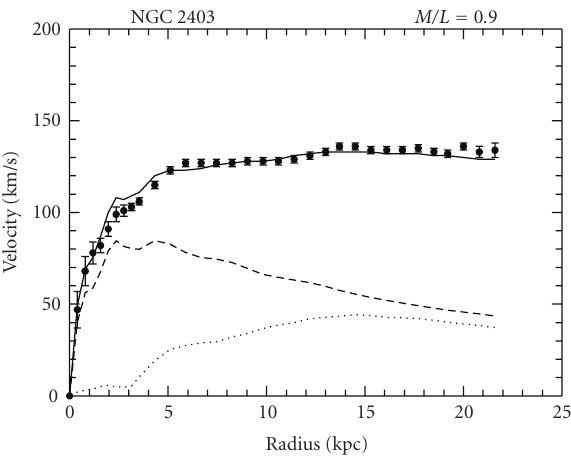
Figure 1: The 21 cm line rotation curve of the spiral galaxy NGC 2403 (points with error bars). The dashed curve shows the Newtonian rotation curve of the visible disk, assuming a constant mass-to-light ratio of 0.9 in solar units. The dotted curve is Newtonian rotation curve due to the gaseous component (hydrogen plus primordial helium). The solid curve is the MOND rotation curve. One should bear in mind that such theoretical curves also possess error bars, or a range of confidence, due to observational uncertainties in the baryonic mass distribution.